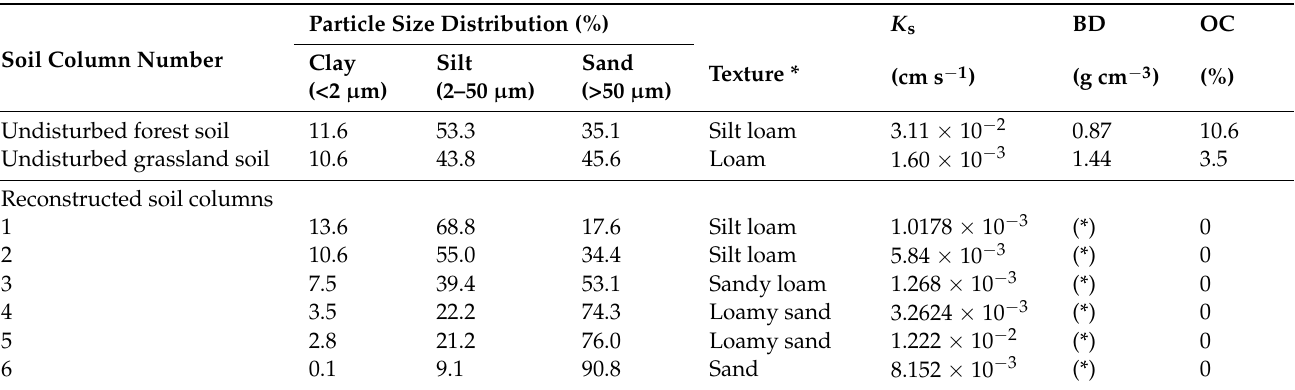
Table 1. Measured texture, saturated hydraulic conductivity ( K s ), bulk density (BD) and organic carbon (OC) of investigated soils used for the